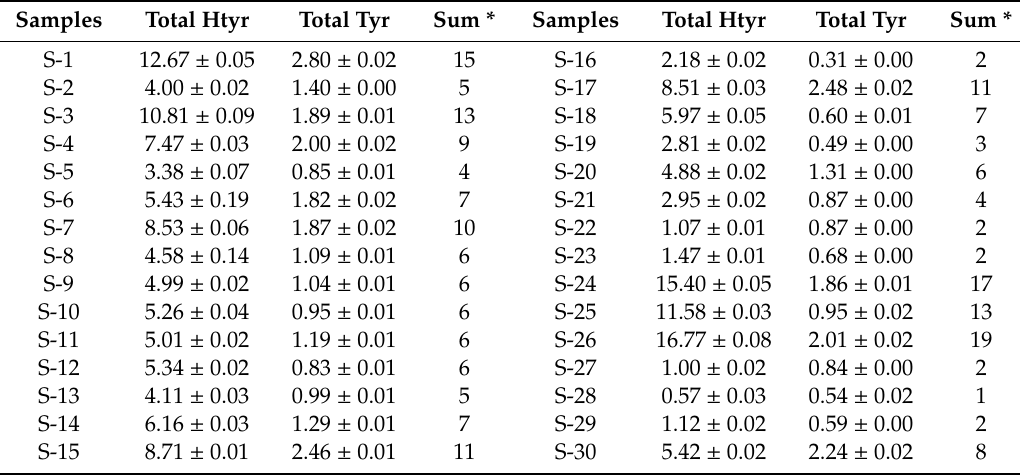
Table 4. Total (free and bound forms) Htyr and Tyr content (mg/20 g oil) of VOO samples according to protocol D.